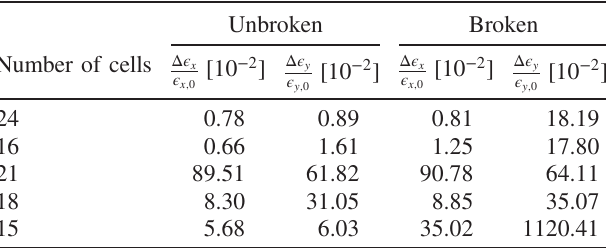
TABLE IX. Relative emittance growth for regular FODO lattices with different number of cells (unbroken) and FODO lattices with different number of cells, but shortened bends in one lattice cell (broken). Here broken and unbroken refers to the breaking of the lattice symmetry by shortening the bends in one